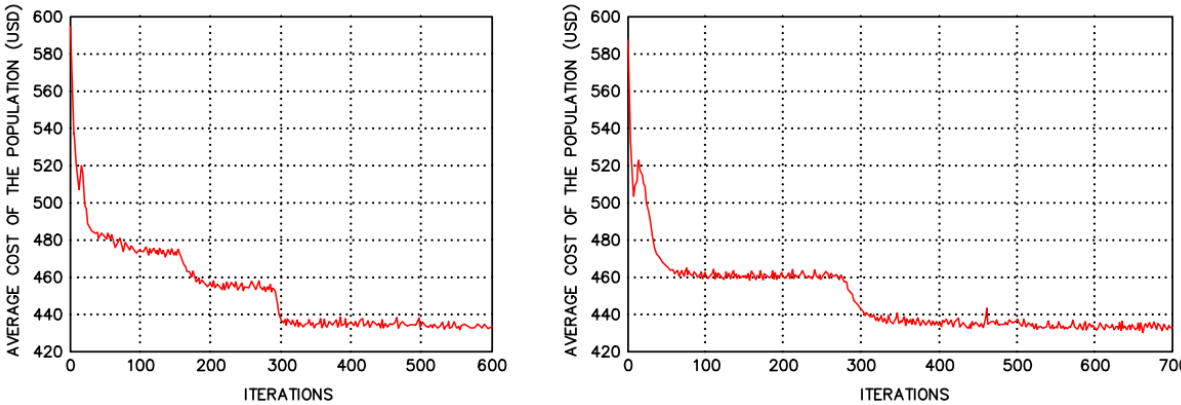
Figure 7. Variation in the mean value of the Fitness Function for simulations with 600 and 700